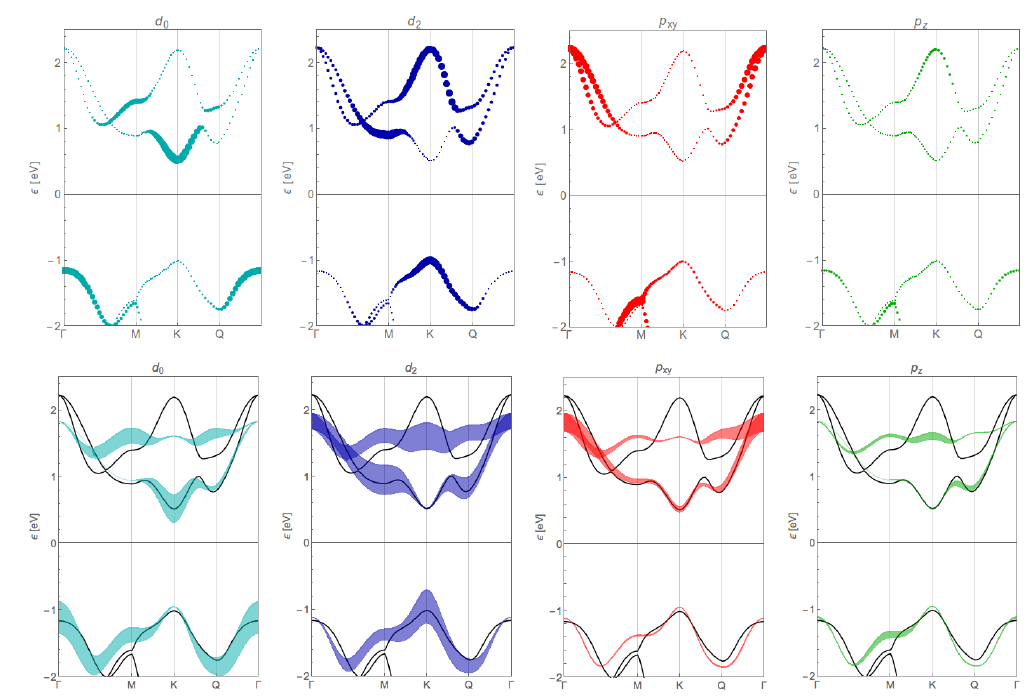
Figure B1. Same as Figure 4 but for MoSe 2 .